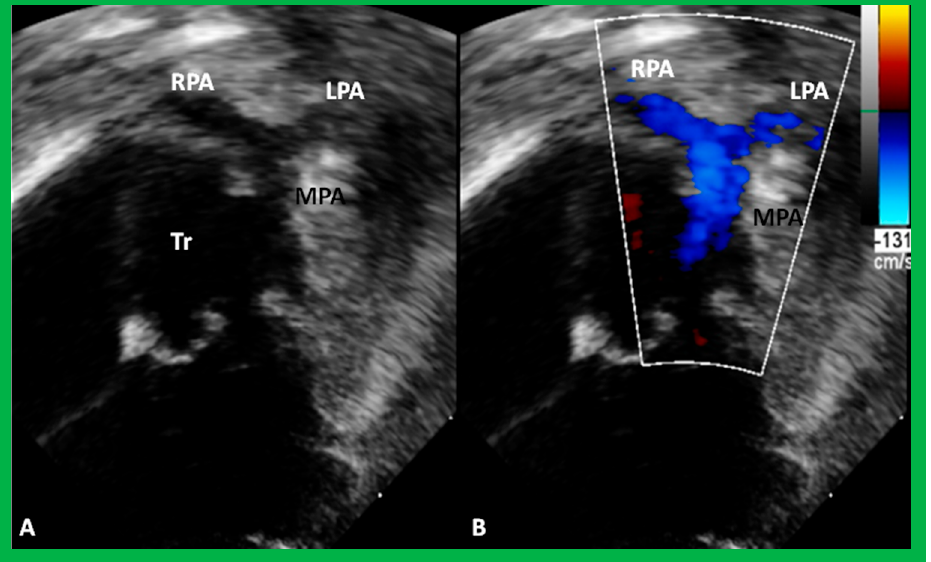
Figure 50. Selected echo frames from modified apical four-chamber views demonstrating the origin of one great vessel, truncus arteriosus (Tr), from the heart. Two dimensional ( A ) and color flow ( B ) frames demonstrating the origin of the main pulmonary artery (MPA) from the left of the Tr bifurcating into the right (RPA) and left (LPA) pulmonary arteries are shown. Replicated from reference [44].